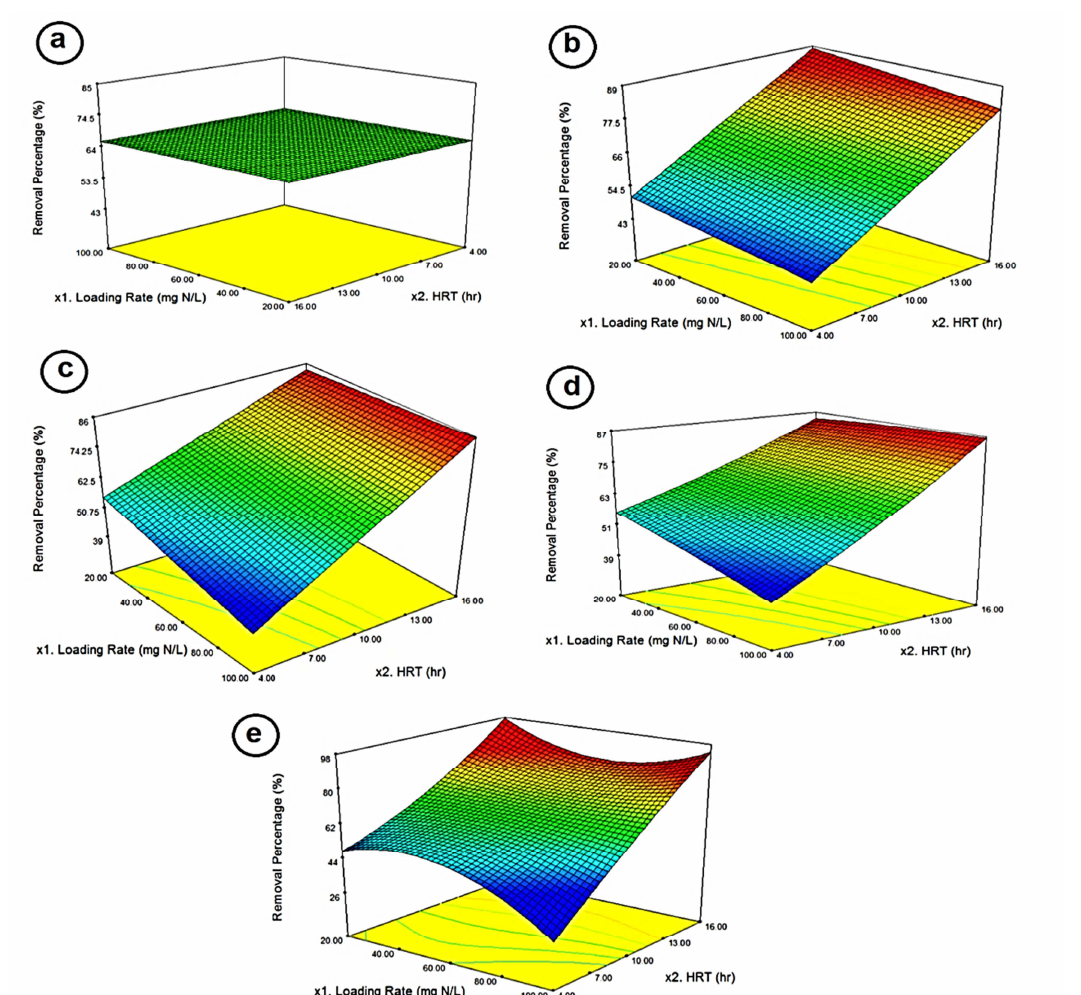
Figure 3. Ammonia byproducts from integrated fixed-film activated sludge (IFAS) process at different loading rates of